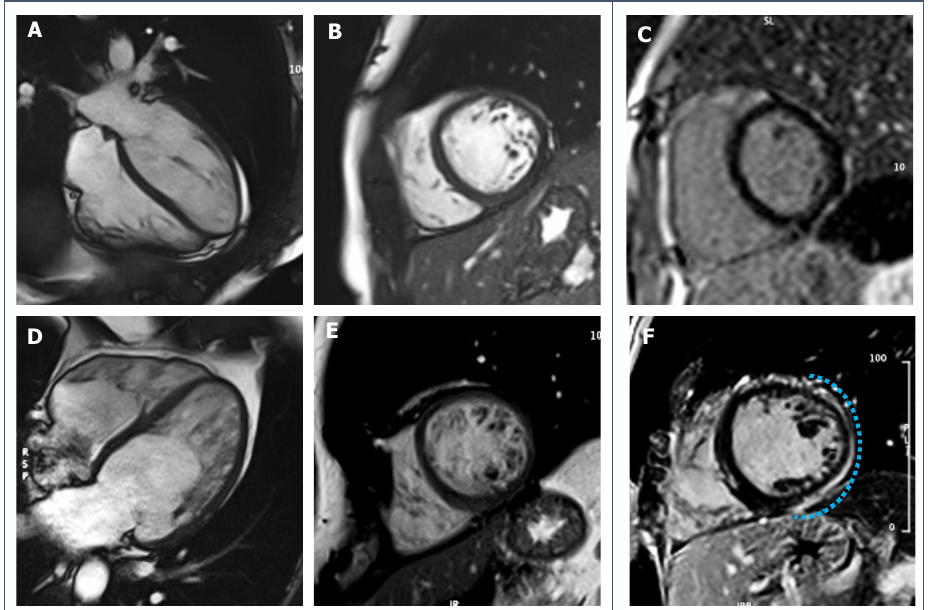
Figure 9. ( A – C ) : 19-year-old healthy male runner with hypertrabeculation of LV in the context of an otherwise normal CMR. ( D – F ): 23-year-old male athlete with a diagnosis of LVNC (later confirmed with genetic testing) with evidence of non-ischemic LGE on post-contrast imaging (blue dotted line). LGE presence may be seen in LVNC, but the sensitivity is not particularly high